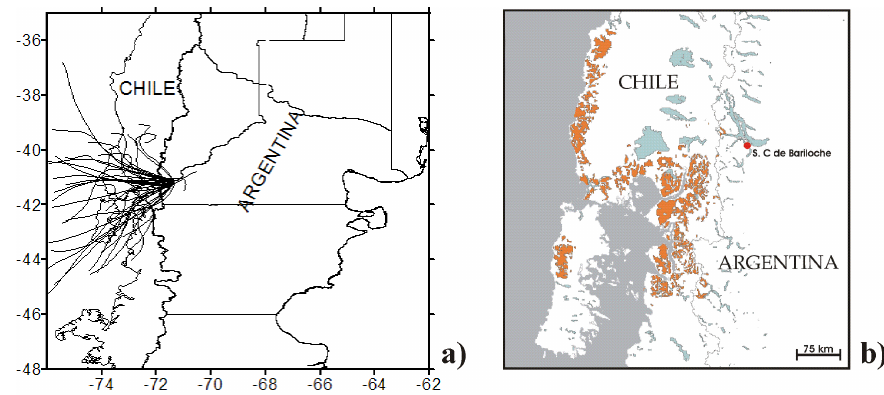
Fig. 2. HYSPLIT 4.6 backward trajectories calculated for the days when Weinmannia pollen was detected in the air of San Carlos de Bariloche. (a) Calculated trajectories. (b) Weinmannia trichosperma source locations.